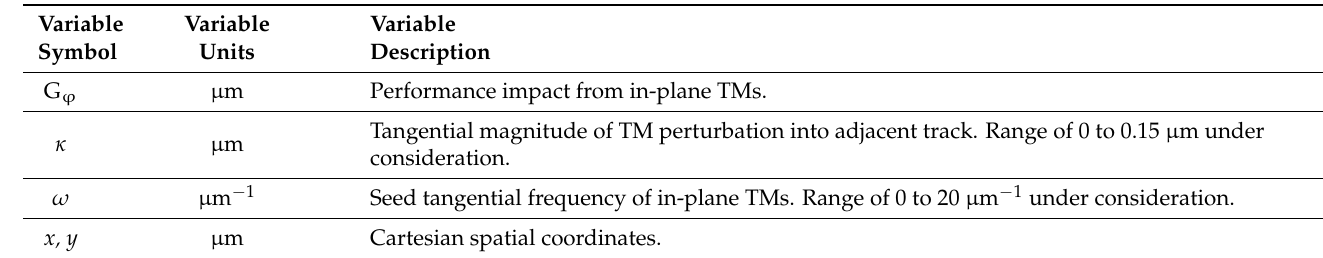
Table 2. In-Plane TM Variable